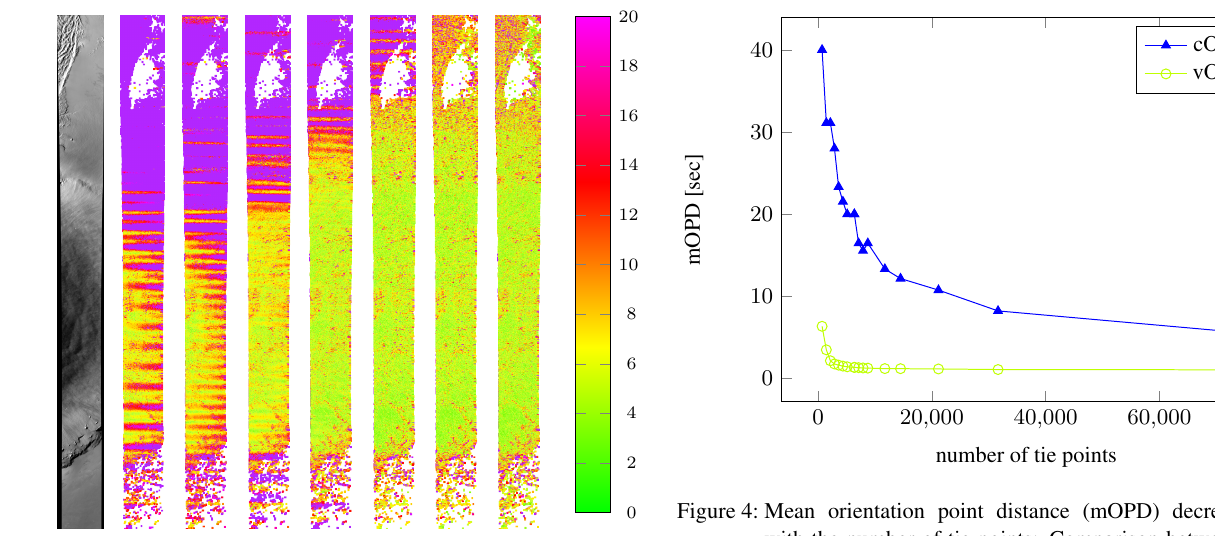
Figure 3: Number of orientation points n O increases with the number of tie points: Comparison between a constant and variable orientation point distance